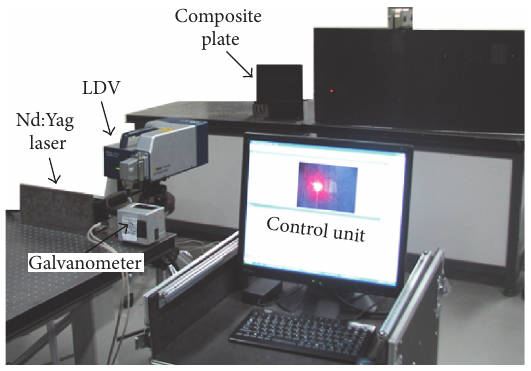
Figure 3: Experimental setup for delamination visualization in a composite